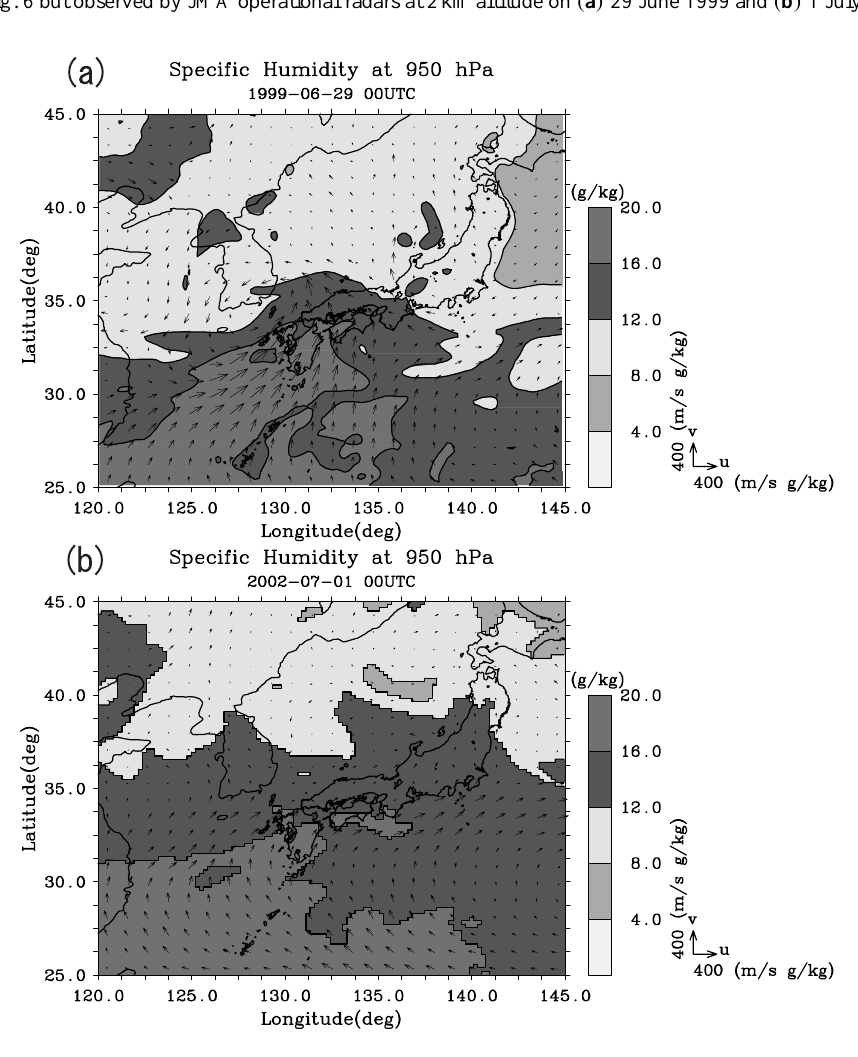
Fig. 8. Horizontal atmospheric fields of specific humidity (contours) and horizontal flux (arrows) at 950hPa